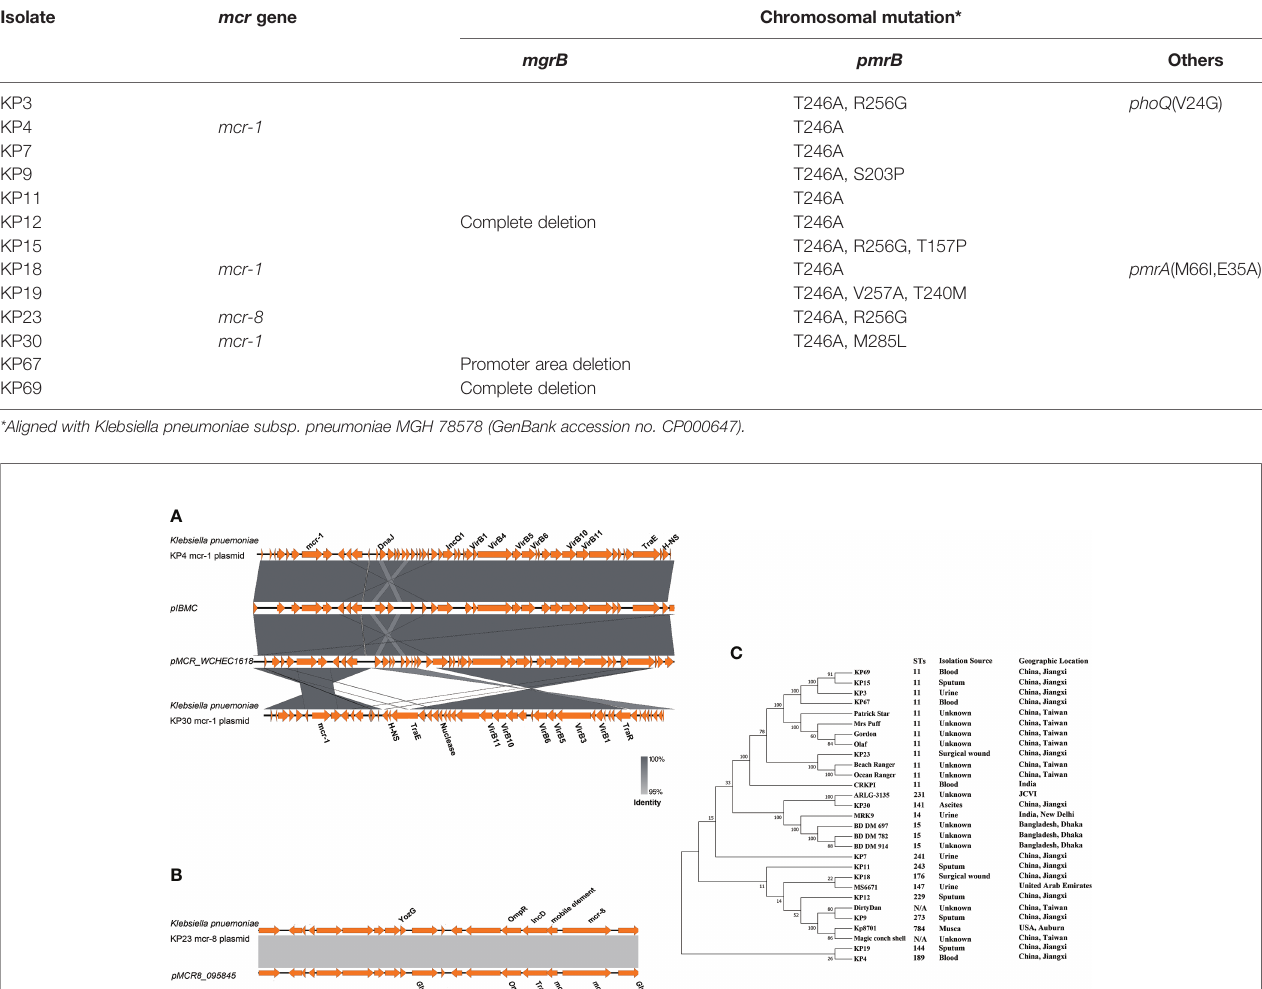
TABLE 3 | Plasmid-mediated genes and chromosomal mutations related to colistin resistance in Klebsiella pneumoniae isolates. Isolate mcr